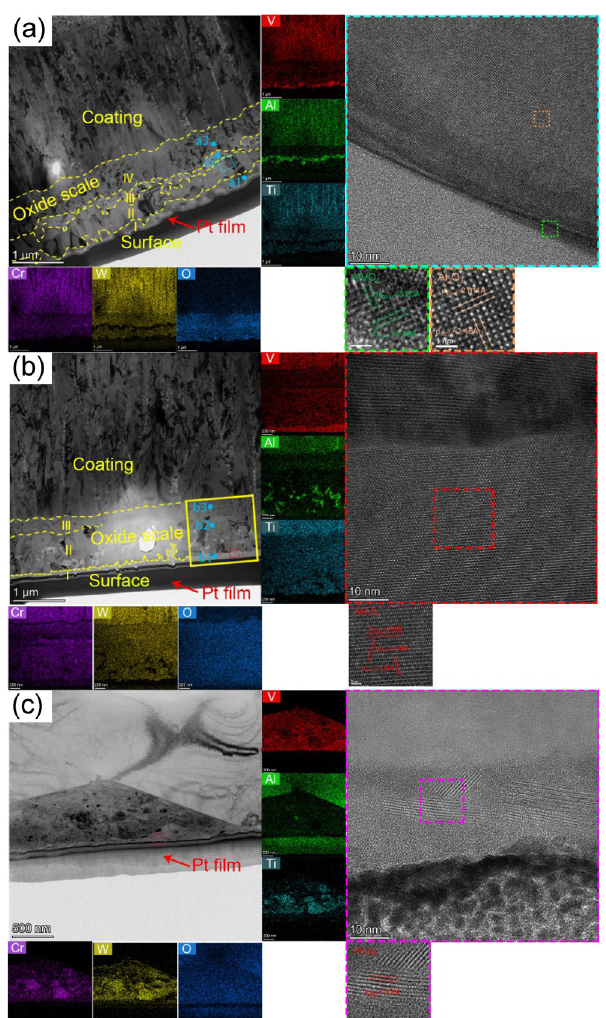
Fig. 7 Cross-sectional TEM images of the film after oxidation at 800 °C (a), wear track of the film after oxidation at 800 °C followed by friction at 700 °C (b), and transfer film on wear scar of its counterpart ball